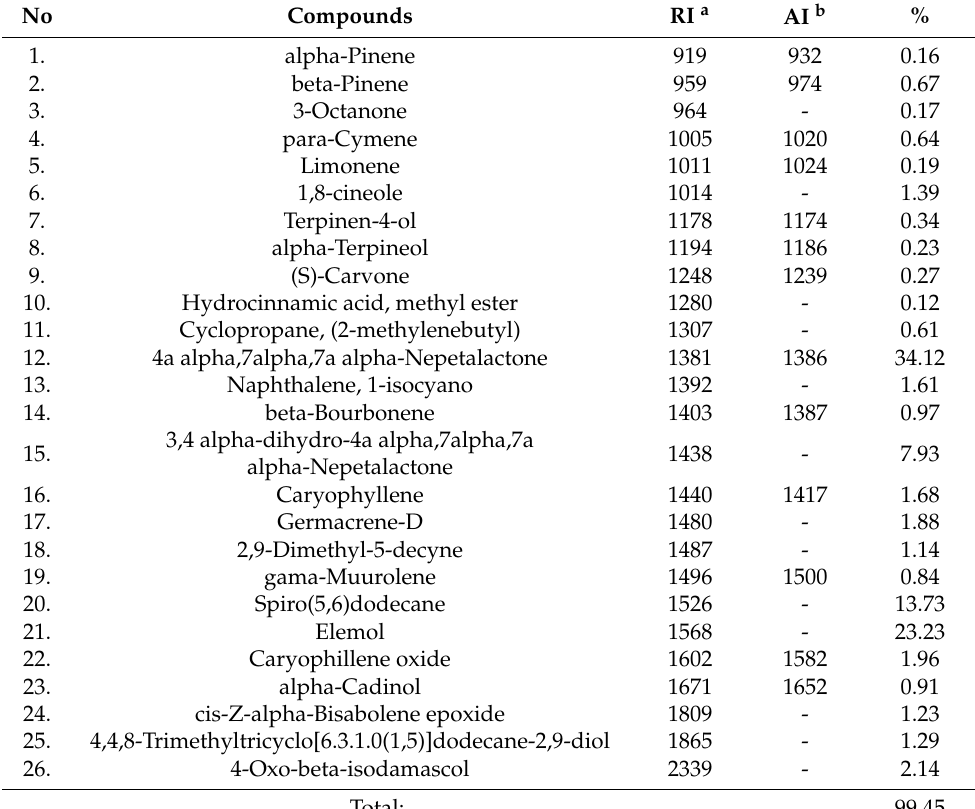
Table 1. Chemical composition of Nepeta × faassenii essential oil (NEO) analyzed by gas chromatog- raphy and mass spectrometry analysis